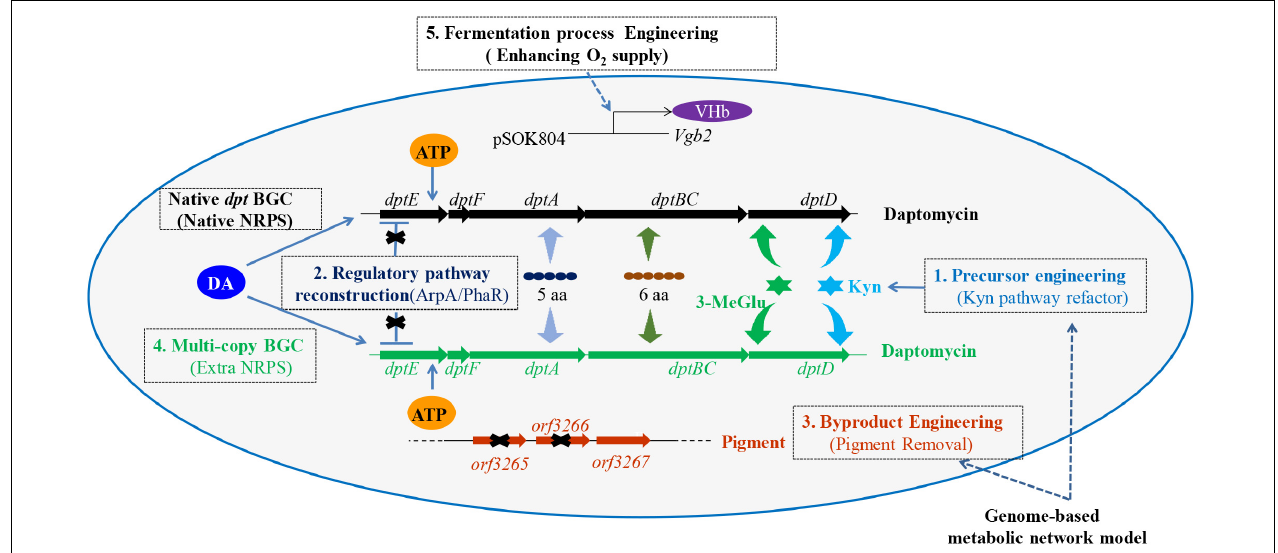
FIGURE 1 | The overview map of metabolic engineering strategies for improving daptomycin production and quality in Streptomyces roseosporus ( S. roseosporus ) L2790. In this study, the multilevel engineering strategies included enhancement of Kyn precursor supply (level 1), reconstruction of the regulatory pathway (level 2), byproduct engineering (level 3), multicopy of BGC (level 4), and fermentation process engineering (level 5). Kyn, kynurenine; 3-MeGlu, 3 (cid:48) -methylglutamic acid; 6 aa, six amino acids (Orn 6, Asp 7, D-Ala 8, Asp 9, Gly 10, D-Ser 11); 5 aa, five amino acids (Trp 1, D-Asn 2, Asp 3, Thr 4, Gly 5); DA, decanoic acid; NRPS, non-ribosomal peptide synthetase; BGC, biosynthetic gene cluster; VHb, Vitreoscilla hemoglobin; Vgb2 , a gene encoding protein VHb; pSOK804, an overexpression vector; dptE , dptF , dptA , dptBC , and dptD are the genes locating in daptomycin BGC and being involved in the biosynthesis of daptomycin; for level 2, the “X” indicates a block of negative regulation; for level 3, the “X” indicates deletion of the relevant genes.